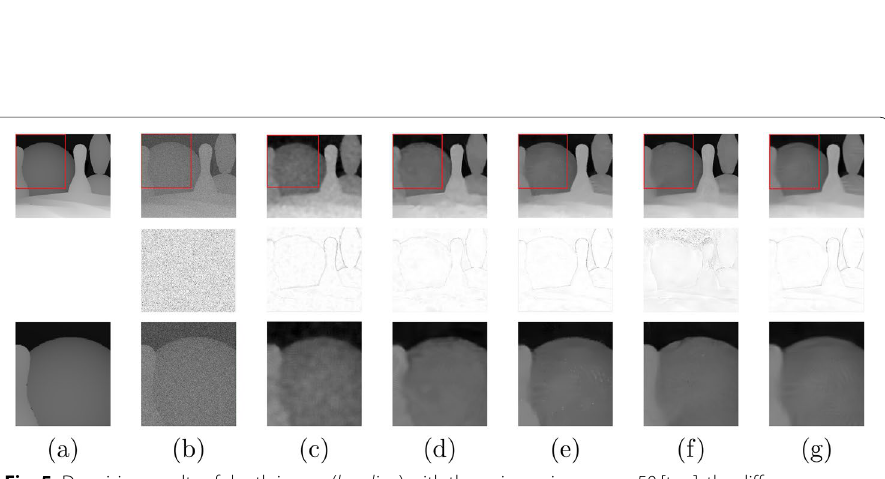
Fig. 5 Denoising results of depth image ( bowling ) with the noise variance σ = 50 [top], the difference between the original depth images and the filtered images [middle], and zoom-in image [bottom]. From the left ( a ) to right ( g ) are: the original image, the noisy image, the results obtained by NLM, BM3D, OGLR, ADnet and the proposed method respectively